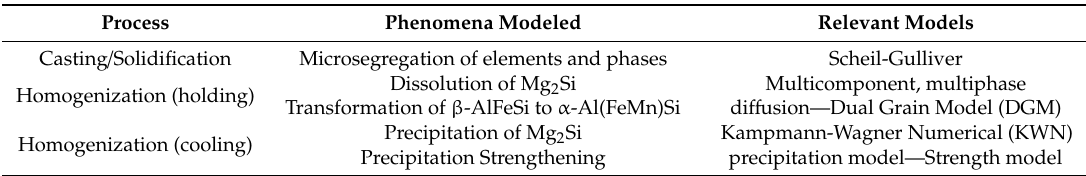
Table 2. Models used in the present